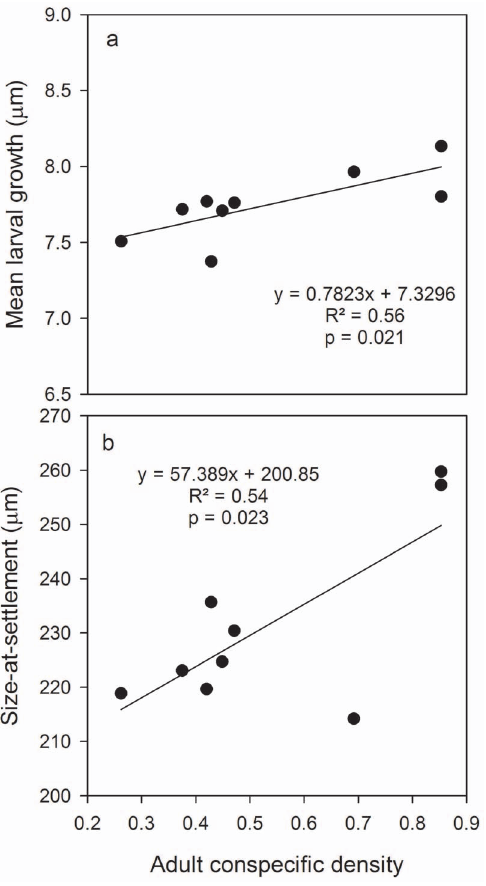
Figure 5. Relationship between mean otolith-derived (a) larval growth and (b) size-at-settlement of Stegastespartitus recruits and adult conspecific density from June 2007 to August 2008.